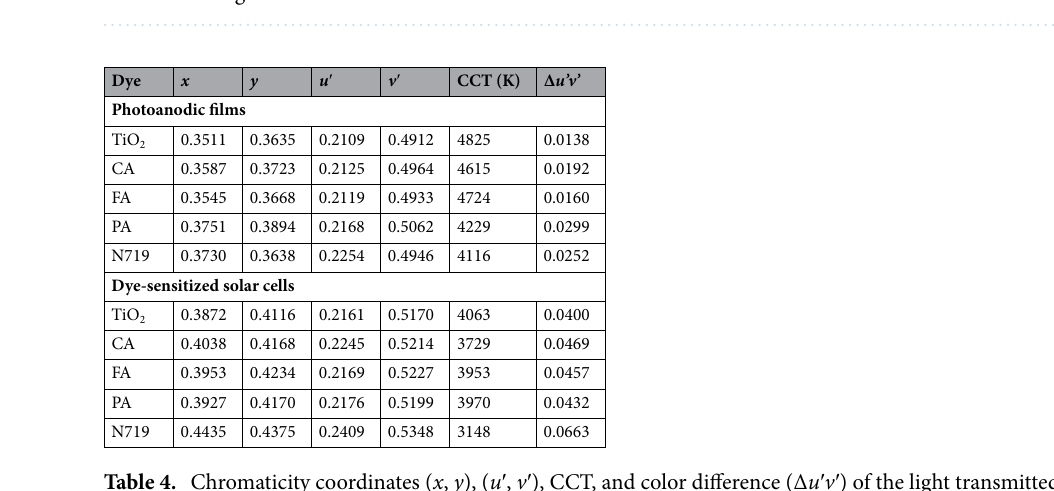
Figure 6. Color coordinates of ( a ) photoanodic films (TiO 2 -only, CA, FA, PA, and N719) and ( b ) their solar cells plotted on the CIE 1931 ( x , y ) and the CIE 1976 ( u ′ , v ′ ) chromaticity diagram. AM 1.5G is also included as the reference light source.